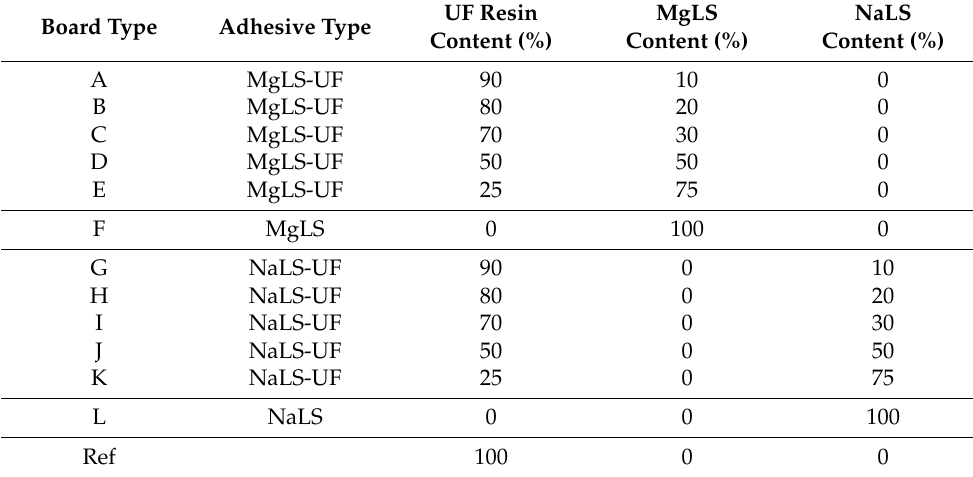
Table 2. Manufacturing parameters of particleboards produced in this